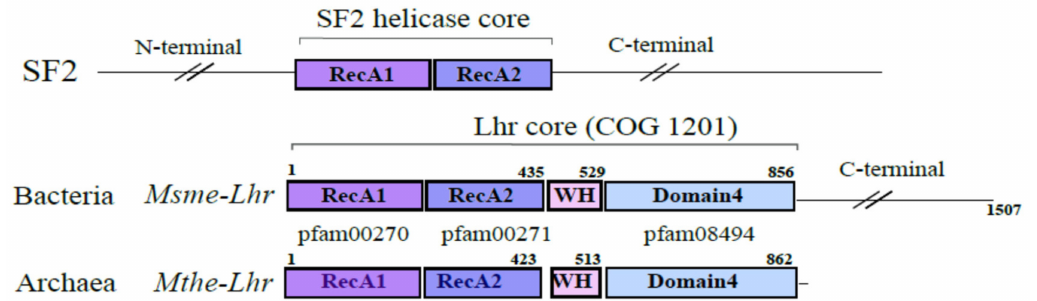
Figure 1. Overall domain organization of SF2 helicase superfamily and Lhr-like subfamily. Lhr proteins of the Mycobacterium smegmatis bacterium and the Methanothermobacter thermautotrophicus archaeon are shown. The “Lhr-core” (COG1201) is composed of the RecA1 (PF00270) and RecA2 (PF00271) domains of the SF2 helicase core, the Winged-Helix domain (WH) and the Domain4 (PF084494) of unknown function that is specific to the Lhr